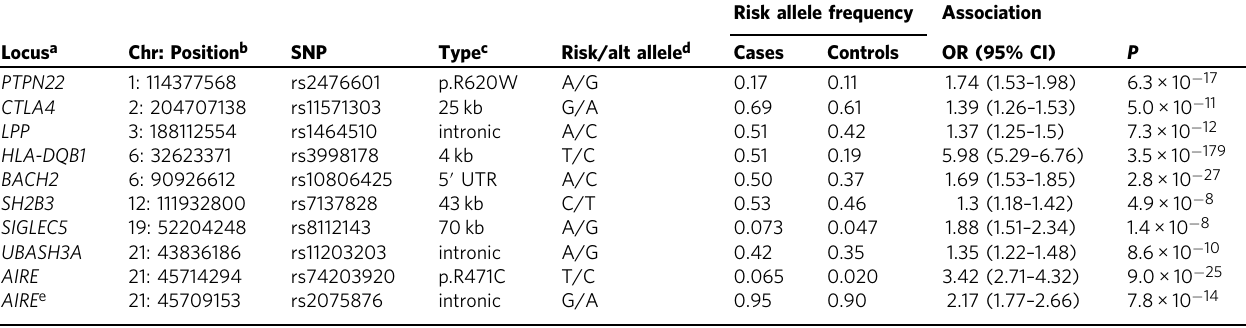
Table 1 Autoimmune Addison ’ s disease risk